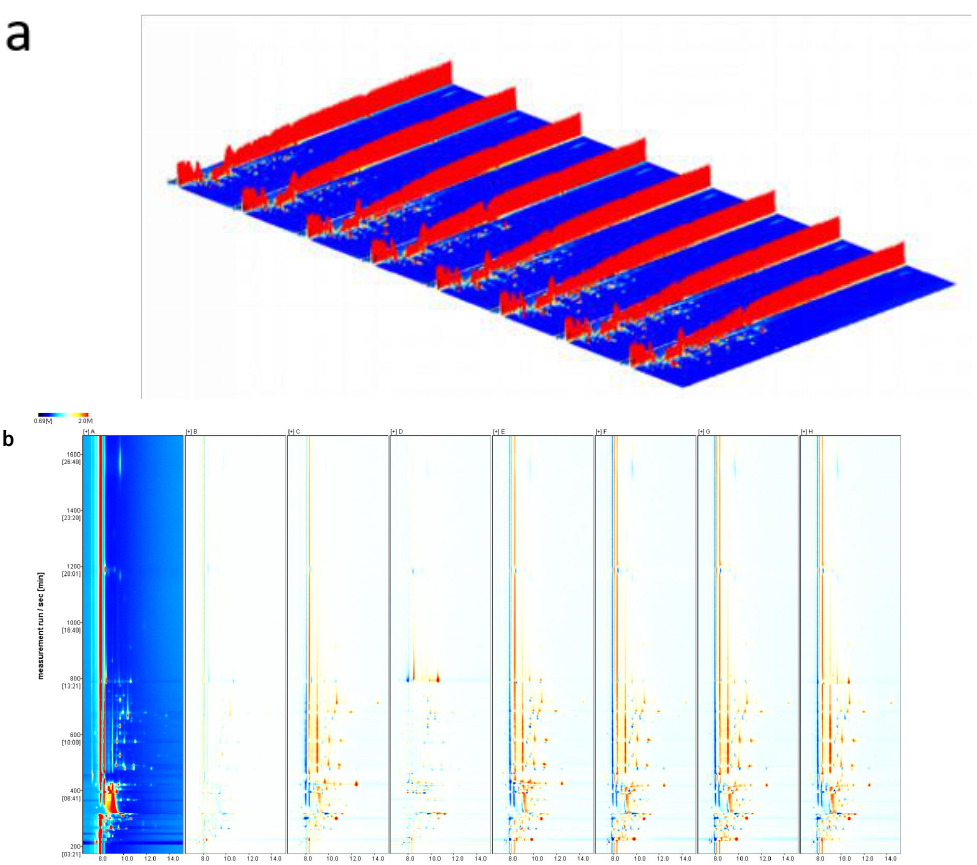
Figure 4. GC-IMS 3D profiles ( a ) and 2D profiles of the volatile flavor substances of the smoked sausages in the different treatment groups ( b